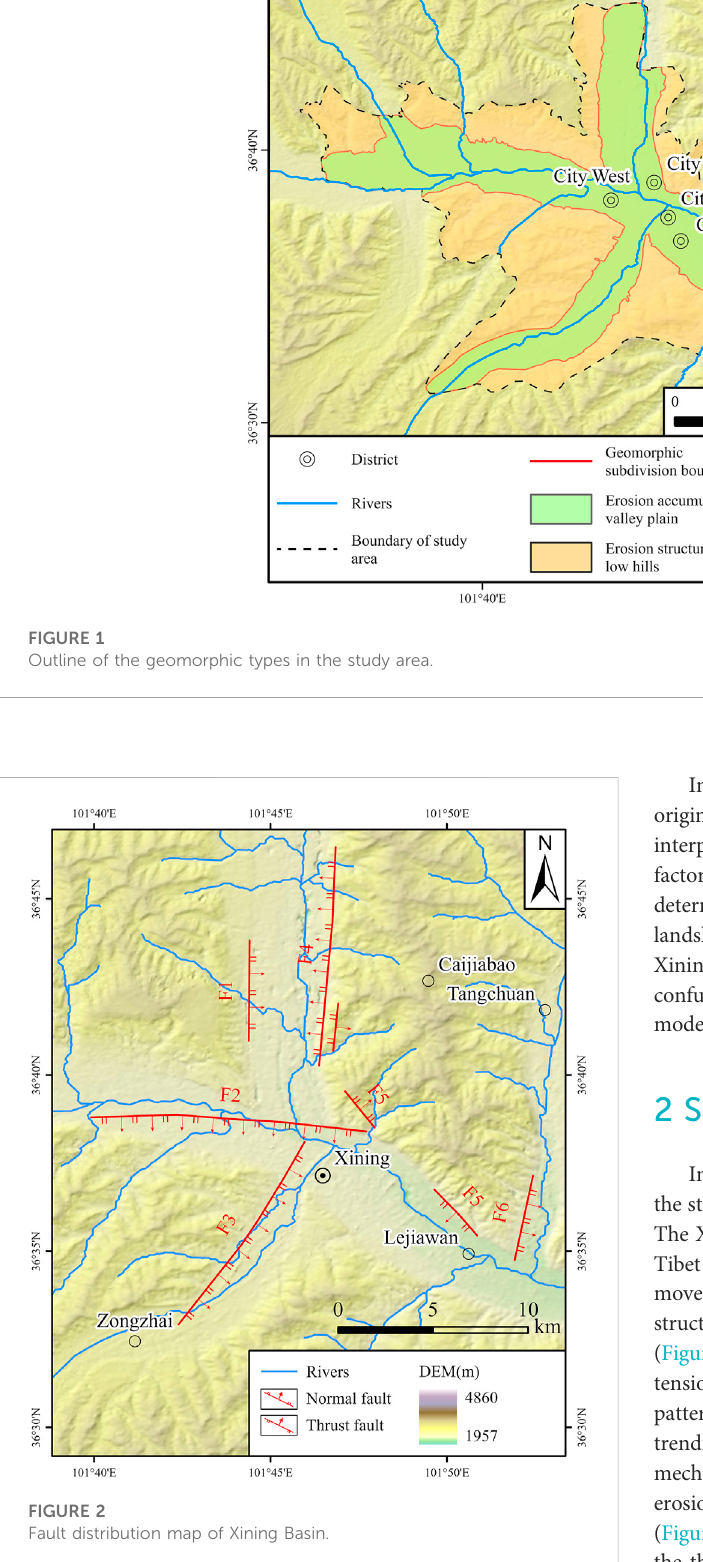
FIGURE 2 Fault distribution map of Xining